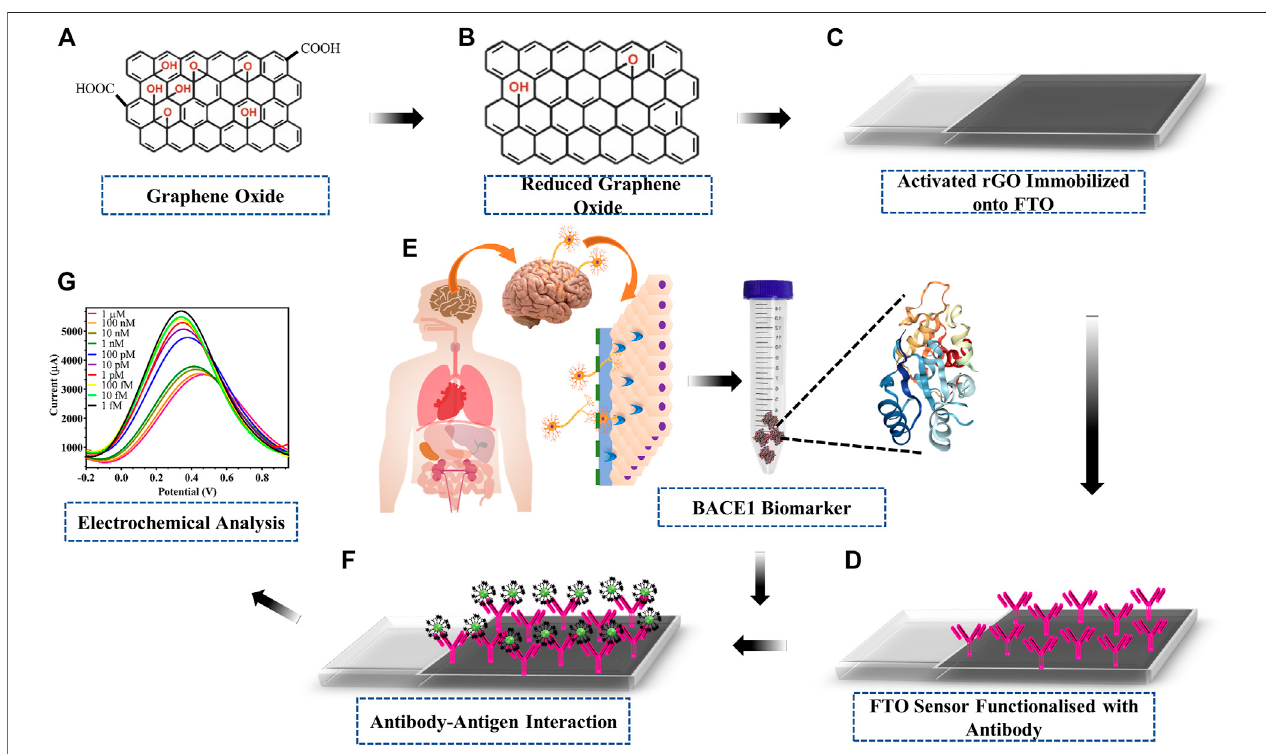
FIGURE1| Schematicoffabricationandworkingofdeveloped electrode: (A) GO; (B) one-stepsynthesisedrGO; (C) activationofrGOviaEDC-NHScarbodiimide coupling chemistry coated on the surface of FTO; (D) immobilization of BACE1 Ab onto activated rGO; (E) Alzheimer ’ s disease BACE1 biomarker protein sample; (F) capture of target BACE1 Ag upon interaction with immobilized BACE1 Ab; (G) electrochemical detection of the current output upon Ab – Ag